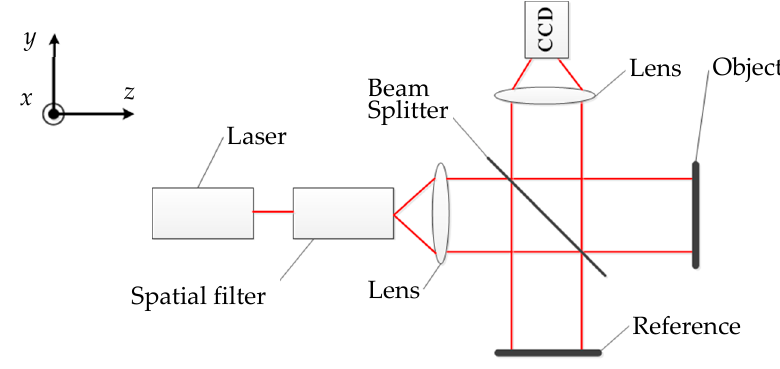
Figure 1. Out-of-plane measurement.